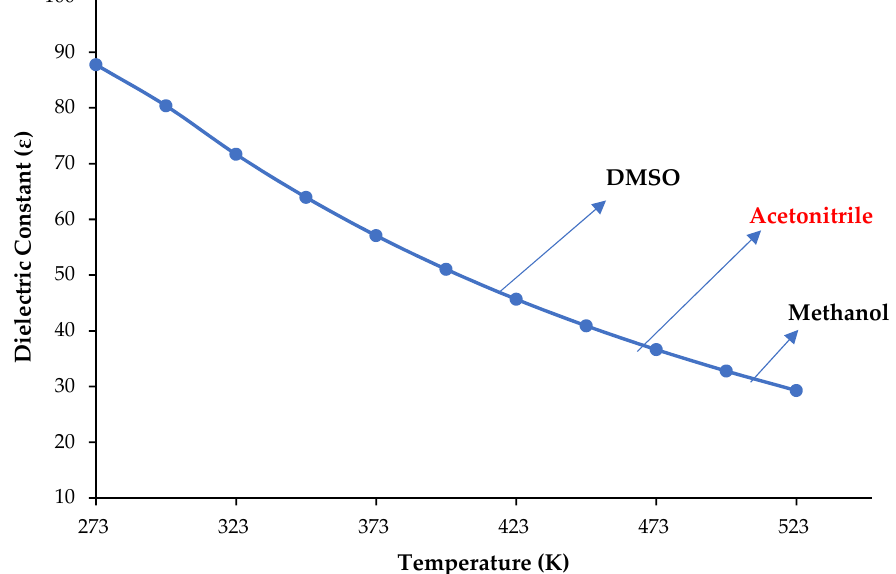
Figure 1. The dielectric constant of water changes with the temperature at 50 bar (data taken from Refs. [1–3]).